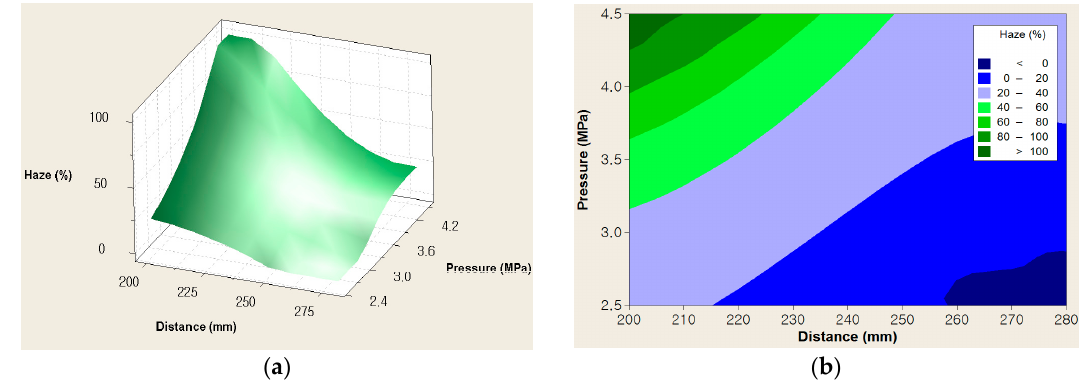
Figure 4. Effects of the distance of the nozzle from the surface of the glass and the nozzle pressure on the haze: ( a ) 3D surface plot; ( b ) contour plot.